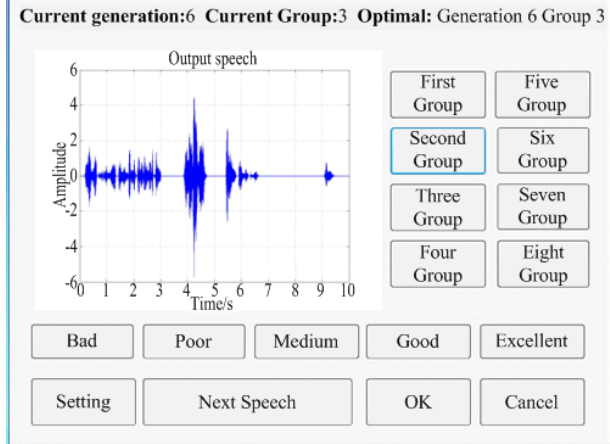
Figure 7. Speech test interface based on the proposed algorithm.